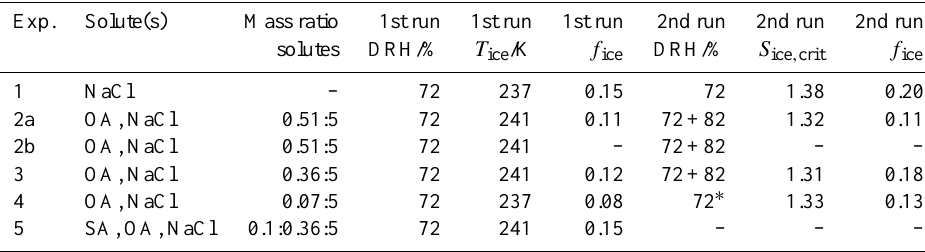
Table 2. Overview of the hygroscopic and ice nucleation behaviour of the investigated aerosol particles in the systems NaCl/H 2 O, NaCl/OA/H 2 O, and NaCl/OA/SA/H 2 O. For the first expansion runs that were started at 244K, the deliquescence relative humidity (DRH), the glaciation temperature T ice of the generated droplet cloud, and the ice-active number fraction of the aerosol population, f ice , are given. For the second expansion runs that were started at 235K, the deliquescence relative humidity, the critical ice saturation ratio S ice , crit at the onset of ice nucleation, and f ice are given. Note that the second expansion run for Exp. 2b was also performed at 244K, yielding a glaciation temperature of 241K as in run